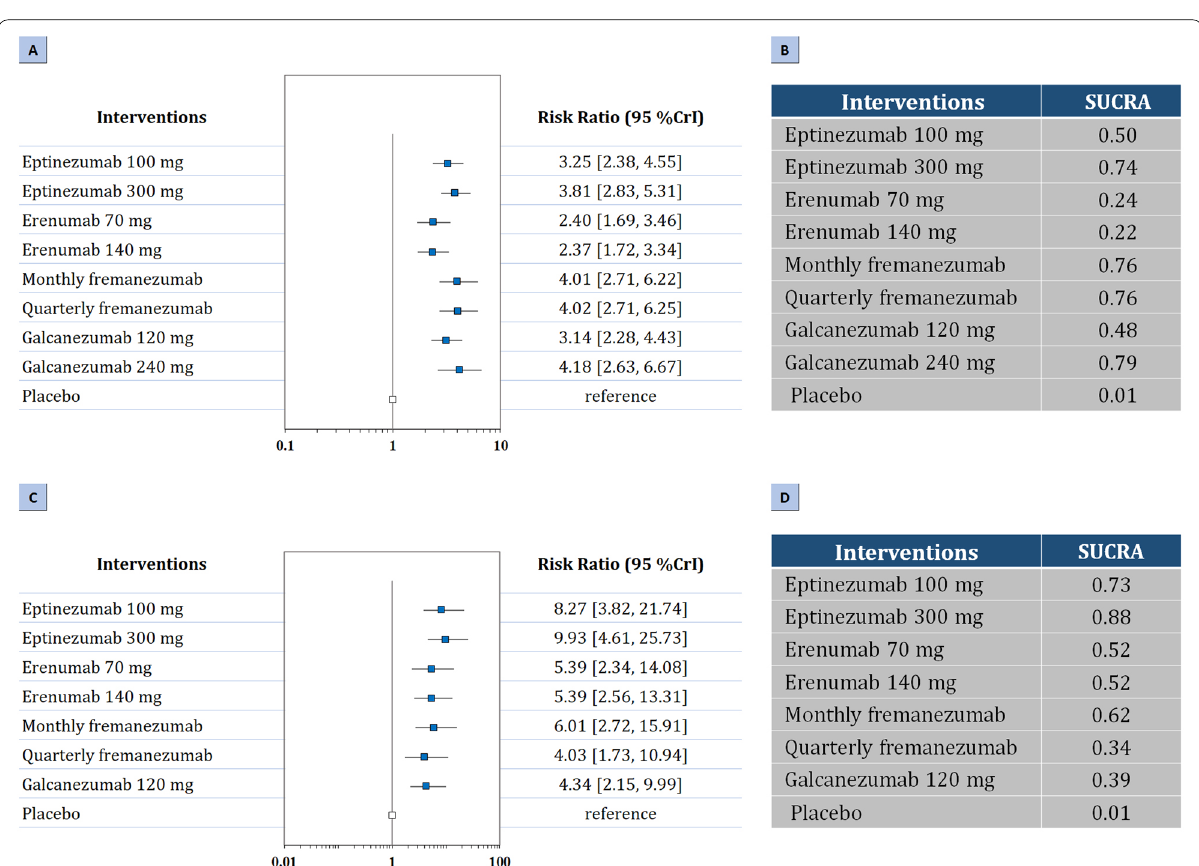
Fig. 2 Summary of the secondary efficacy outcomes. Network plot of ( A ) The forest plot for 50% response rates; ( B ) The SUCRA value of each treatment for 50% response rates. ( C ) The forest plot for 75% response rates; ( D ) The SUCRA value of each treatment for 75% response rates. SUCRA: surface under the cumulative ranking